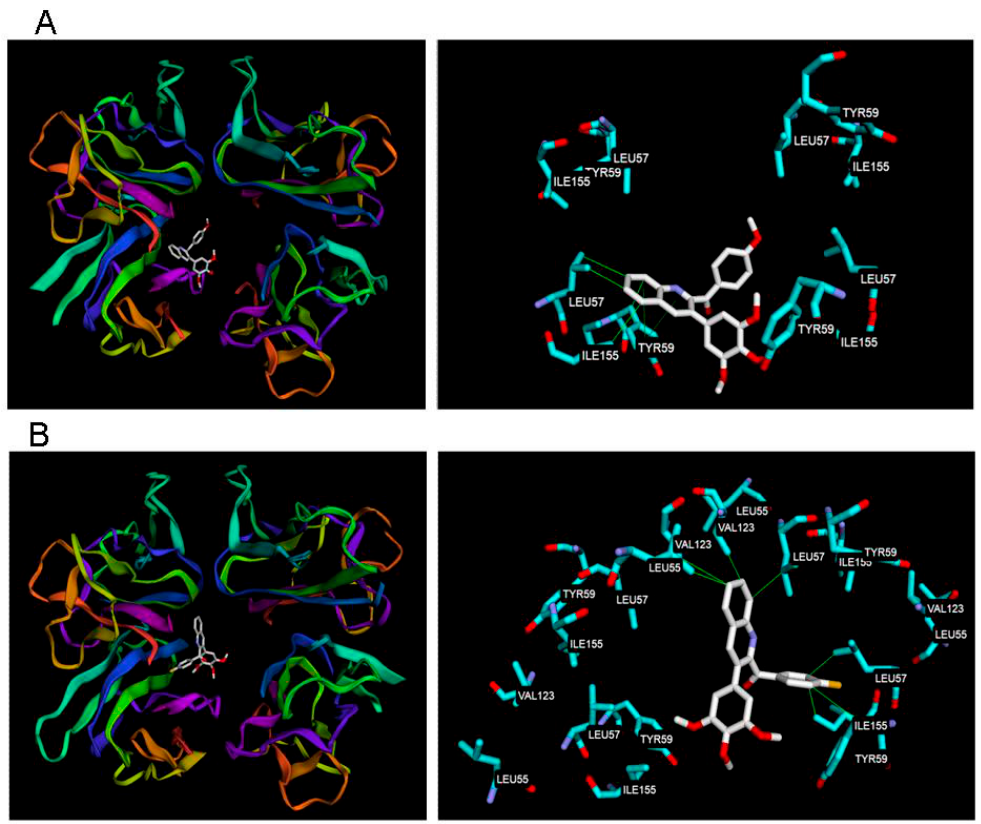
Figure 6. Docking poses of compound 18a ( A ) and 18b ( B ) at the TNF- á (PDB code 2AZ5). The interaction illustrated by green lines represents hydrophobic interaction.